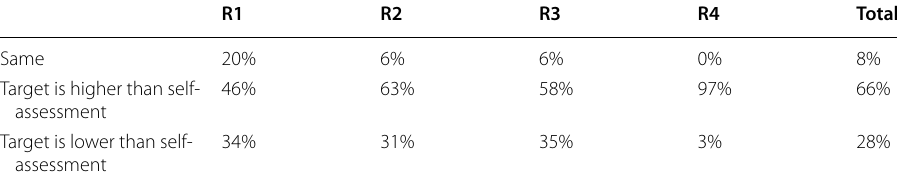
Table 6 Comparison of the modified initial self-assessment and target goal R1 R2 R3 Same